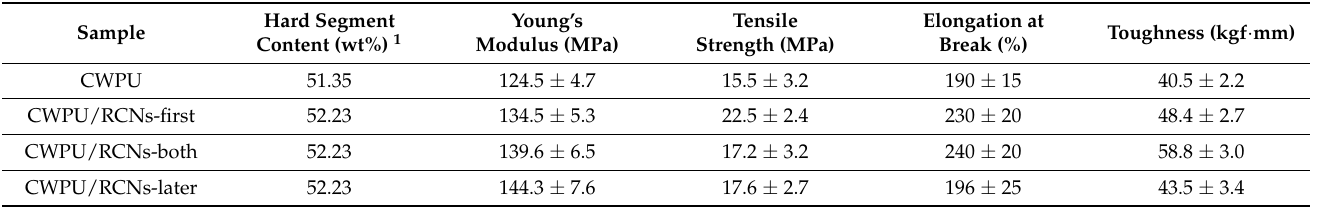
Table 3. Young’s modulus, tensile strength, toughness, and percentage elongation of CWPU and CWPU/RCNs nanocomposite films according to the step of adding RCNs in Figure